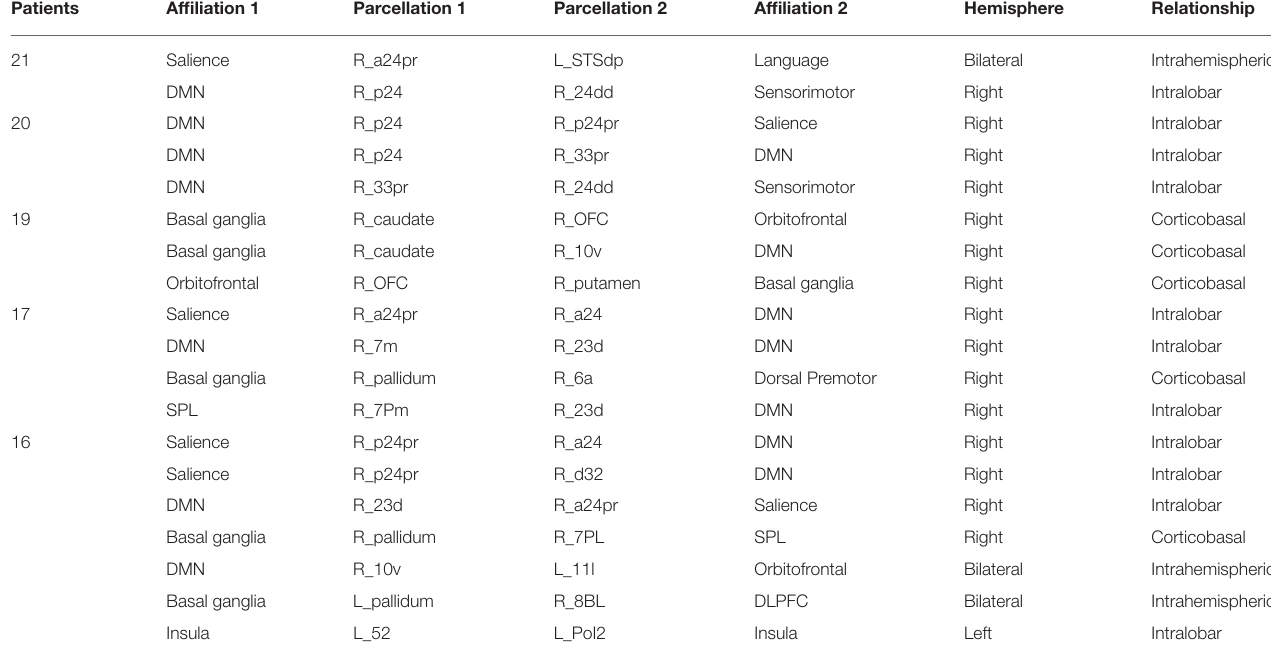
TABLE 4 | Frequency of structural